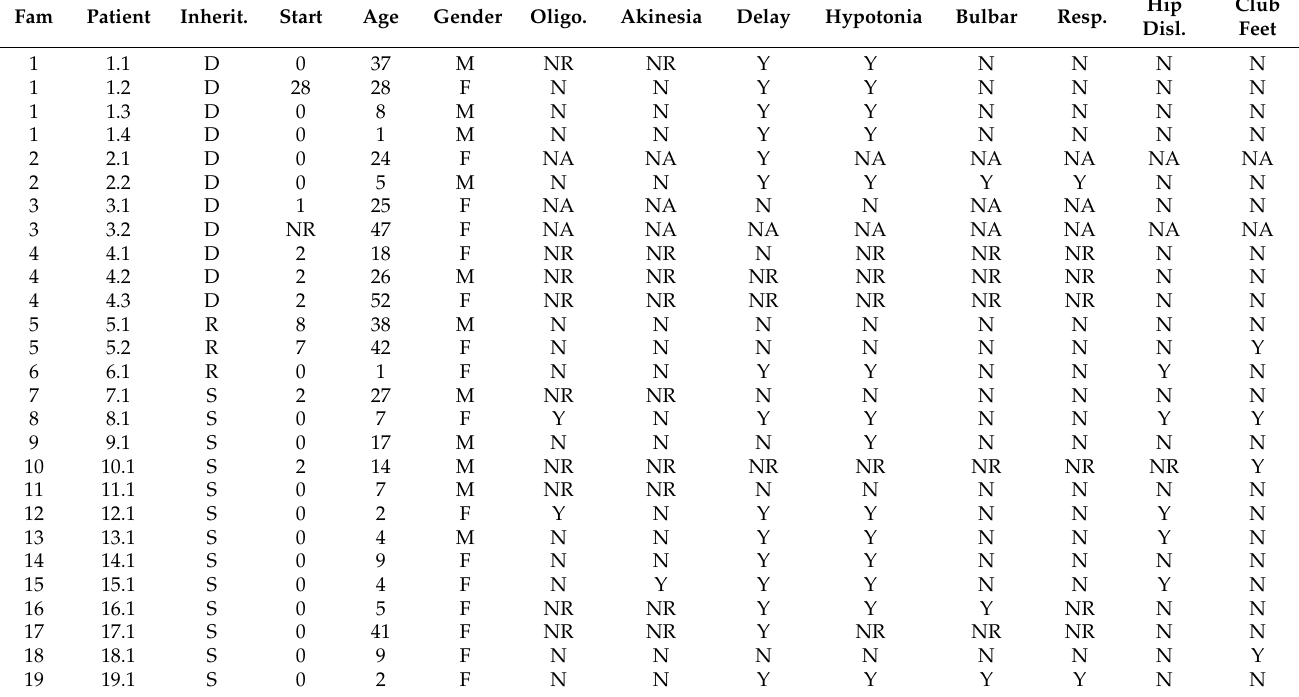
Table 1. Clinical characteristics of 27 Central Core Disease